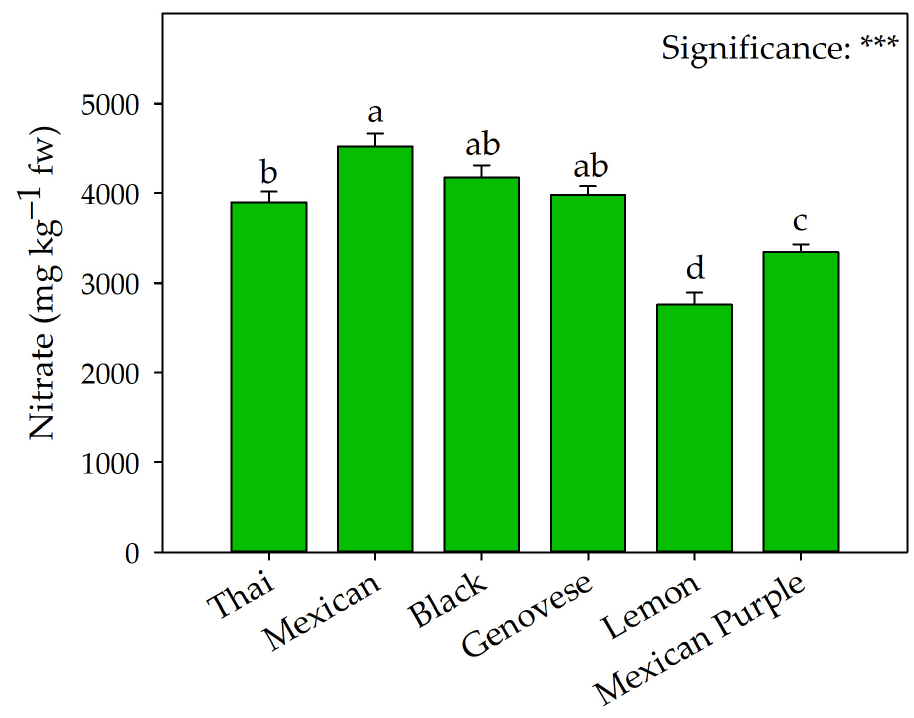
Figure 4. Comparison of Thai, Mexican, Black, Genovese, Lemon, and Mexican Purple basil on nitrate concentration. Data are mean values ± standard error, n = 4. Mean comparisons were performed by Tukey HSD test. Different letters indicate significant mean differences. *** denote significant effects at p ≤ 0.001. fw: fresh weight. Table 4. Comparison of Thai, Mexican, Black, Genovese, Lemon, and Mexican Purple basil mineral